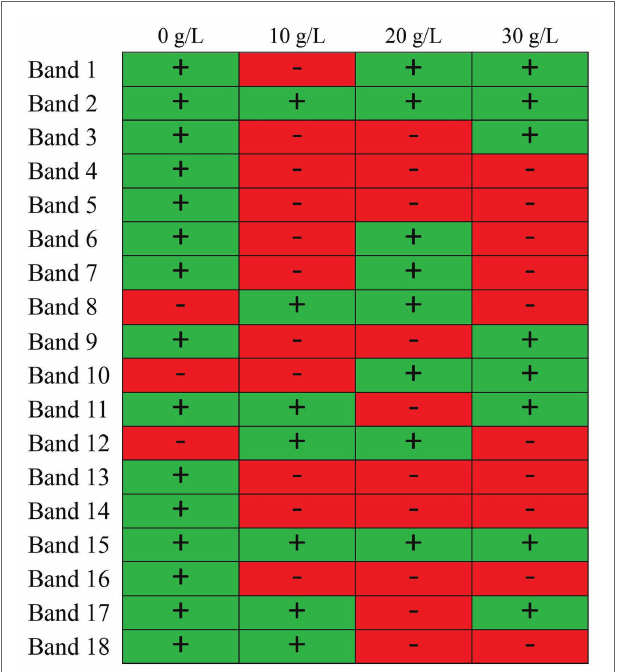
FIGURE 3 | Illustration of bacteria distribution in NaCl assistant anaerobic fermentation system at different NaCl